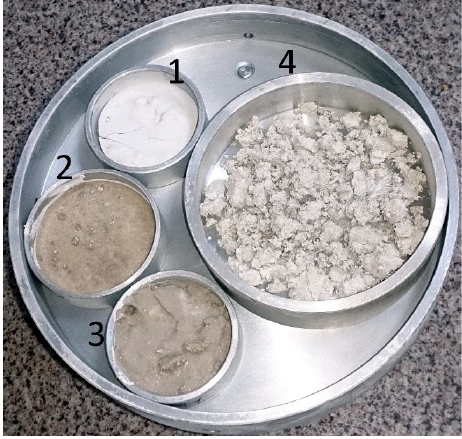
Figure 4 Frozen fractionation products before freeze drying: 1–4 are numbers of corresponding fractions